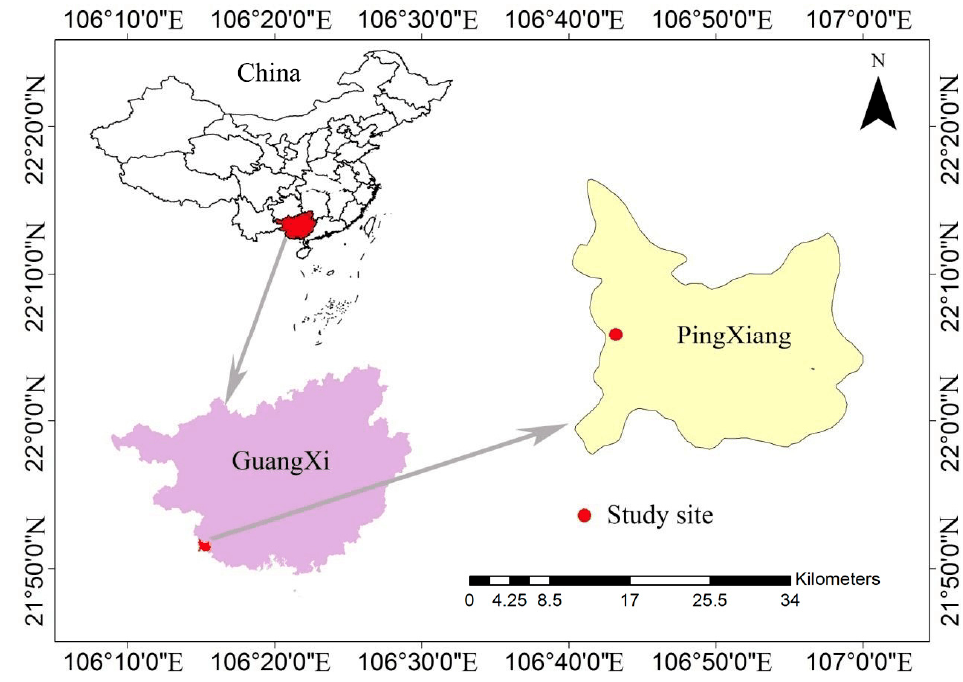
Figure 1. The geographical map of the study site.